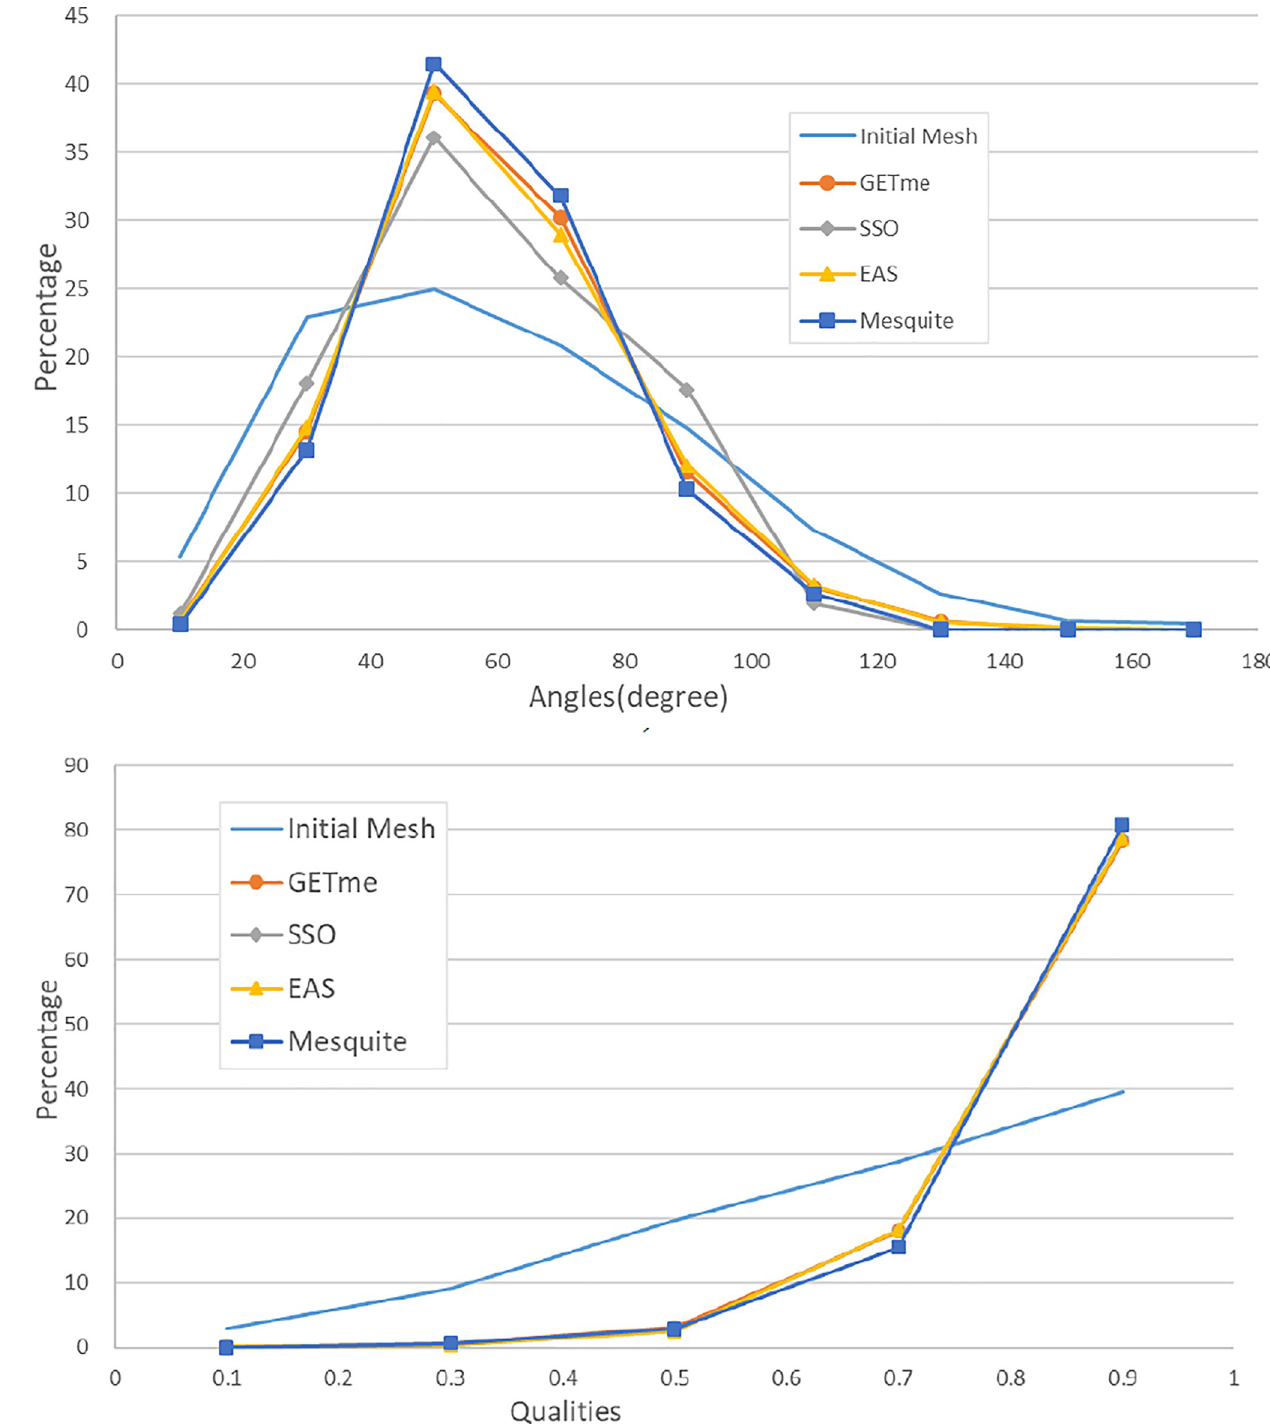
Fig 16. a) Distribution of qualities in Example 5; b) Distribution of angles element in Example 5.